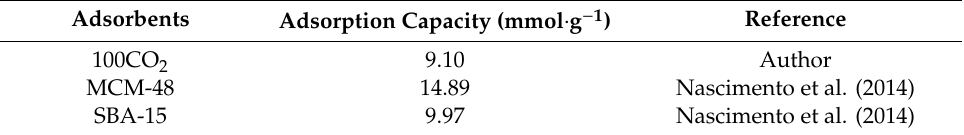
Table 4. CO 2 adsorption capacities obtained at higher